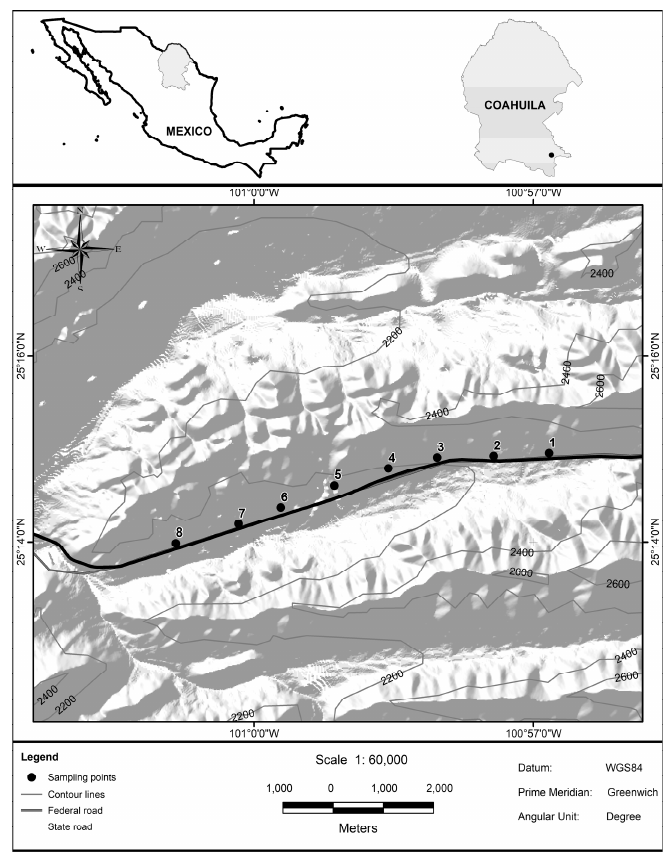
Figure 1. Study site showing the sampling plots located along the pastures analyzed and the location in the Coahuila State, Mexico.